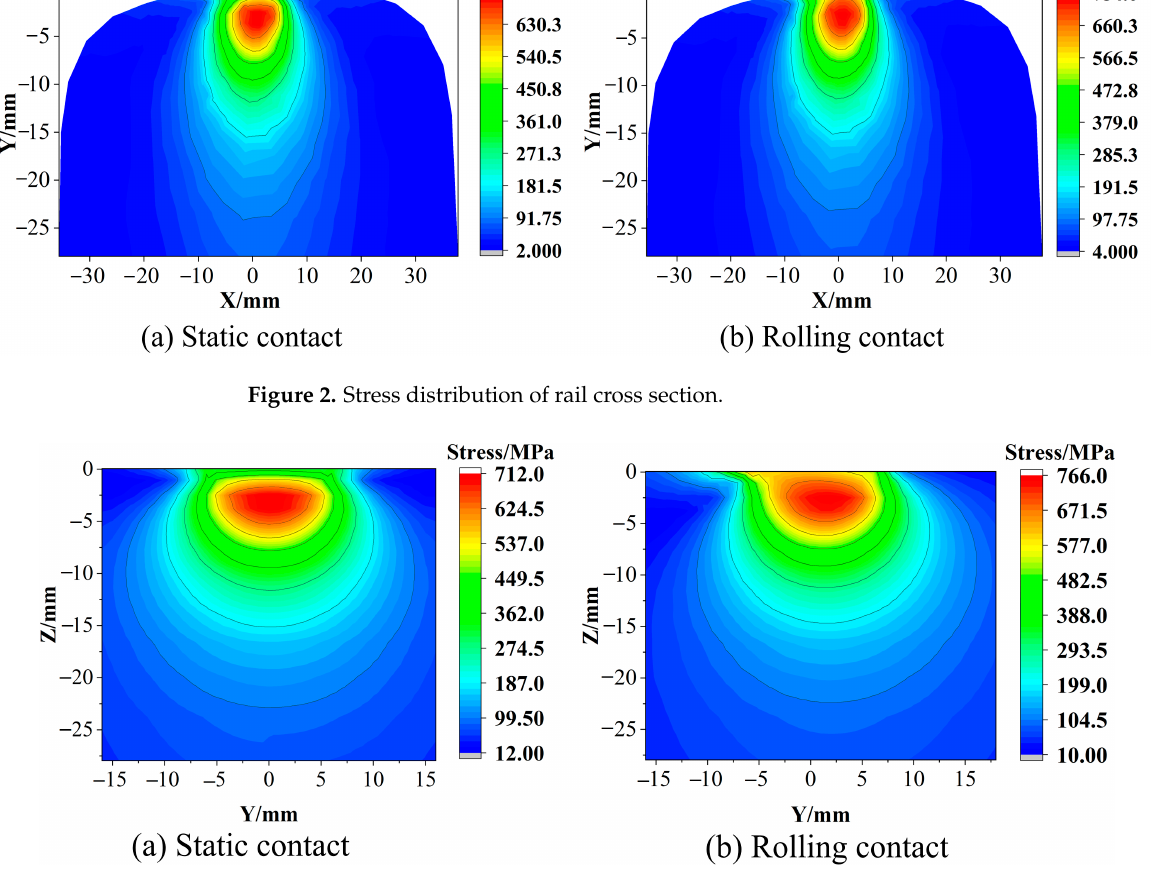
Figure 3. Rail longitudinal section stress distribution.